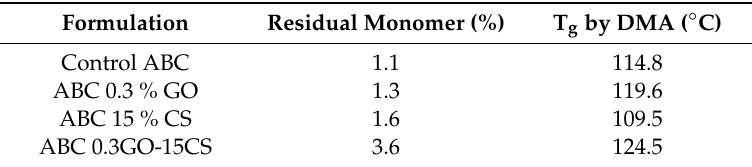
Table 1. Residual monomer and glass transition temperature of ABCs.